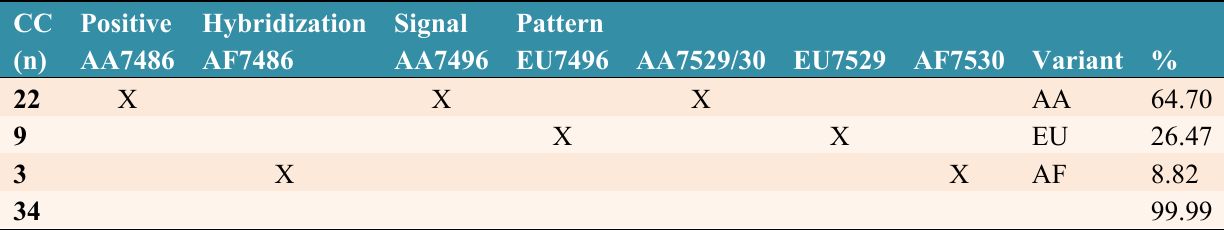
Table 2. Positive signal patterns for CC samples showing variant